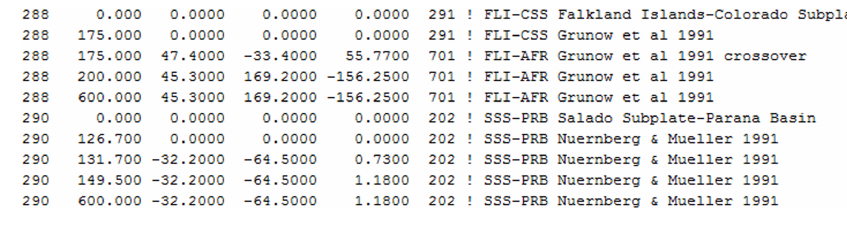
Fig. 22. A snippet of rotation file.